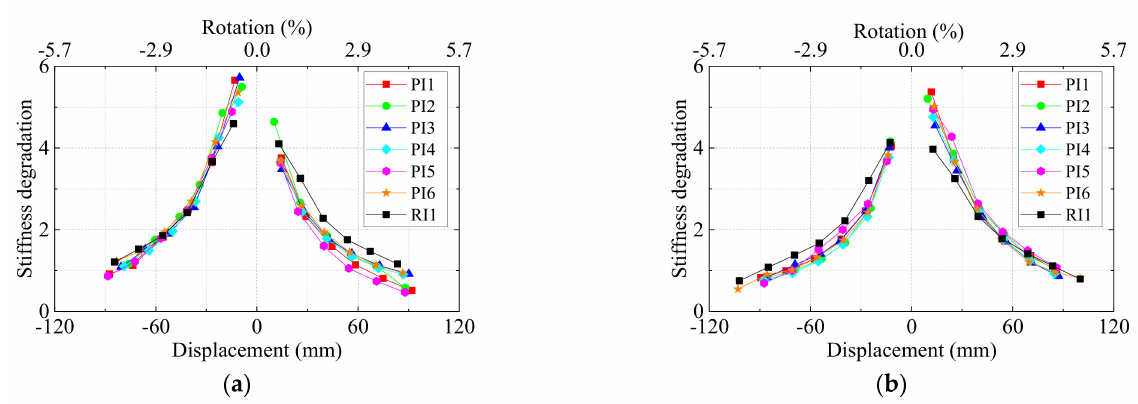
Figure 12. Stiffness degradation. ( a ) Left beams and ( b ) right beams.